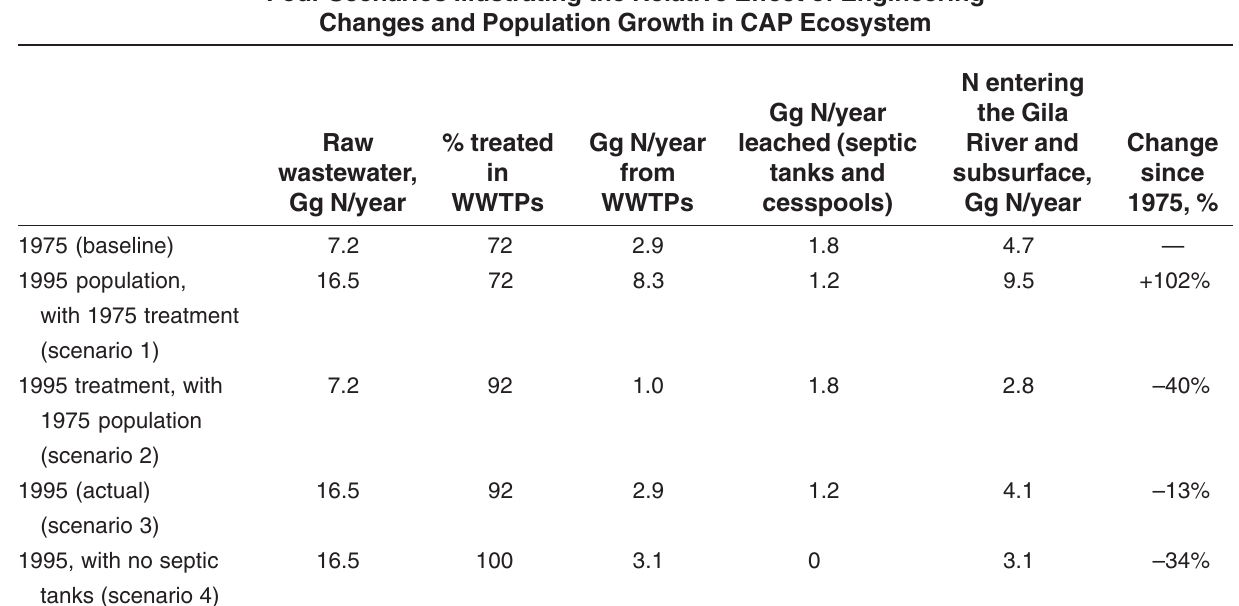
Four Scenarios Illustrating the Relative Effect of Engineering Changes and Population Growth in CAP